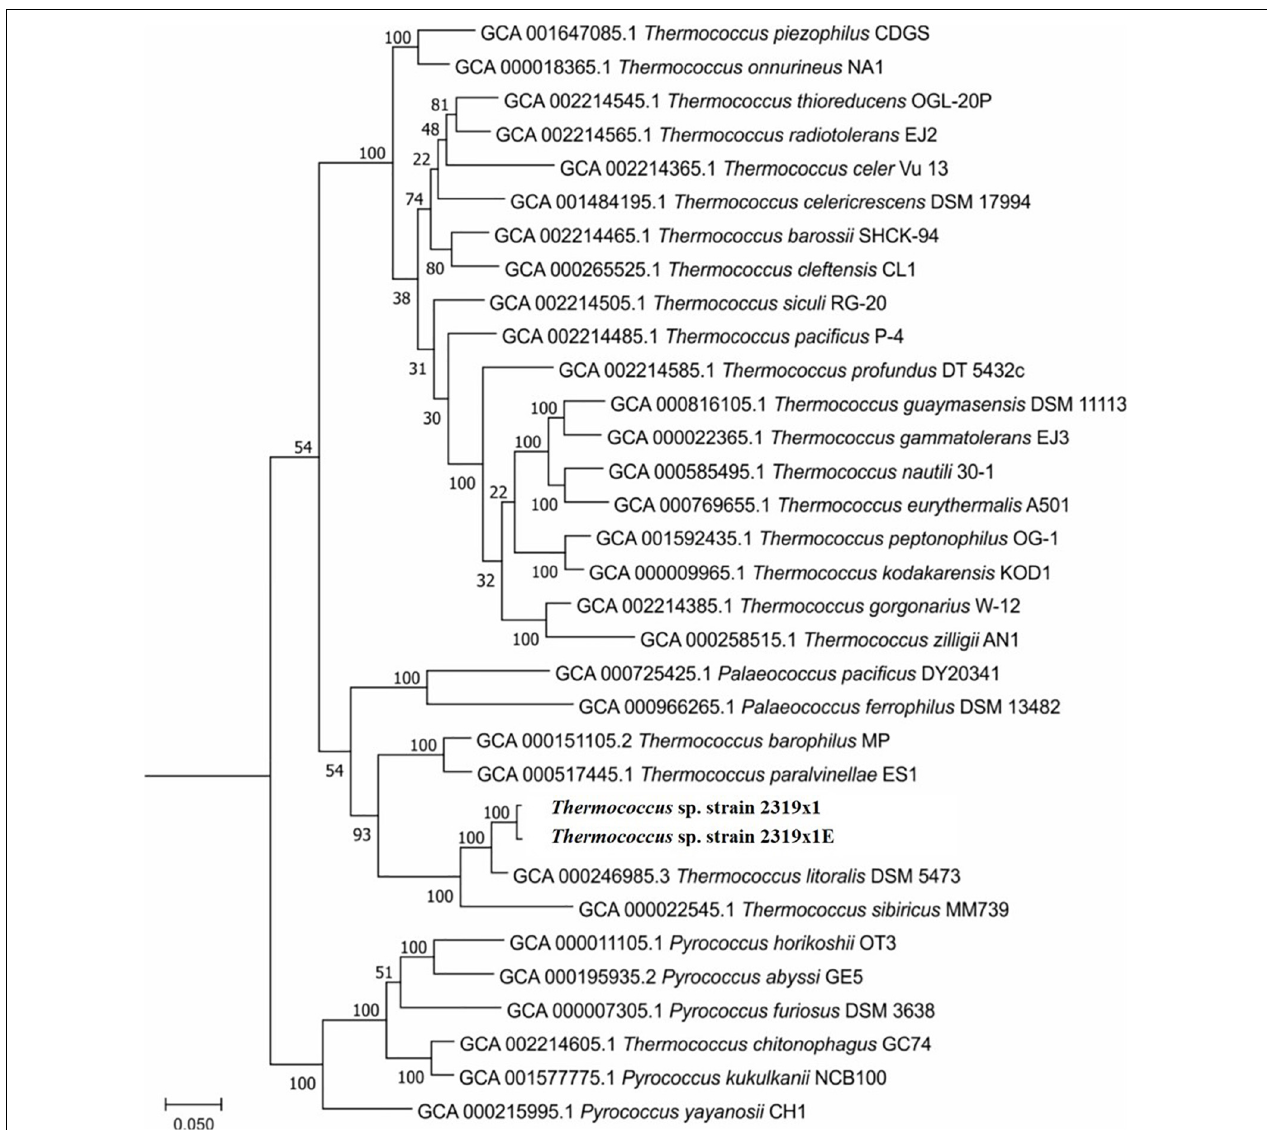
FIGURE 2 | Phylogenetic position of the novel Thermococcus sp. strain 2319x1E in comparison with all available cultivated genomes of Thermococcus , Pyrococcus , and Palaecoccus species. Tree construction was done in RAxML v. 8.2.12 with the PROTGAMMAILG model of amino acid substitutions.